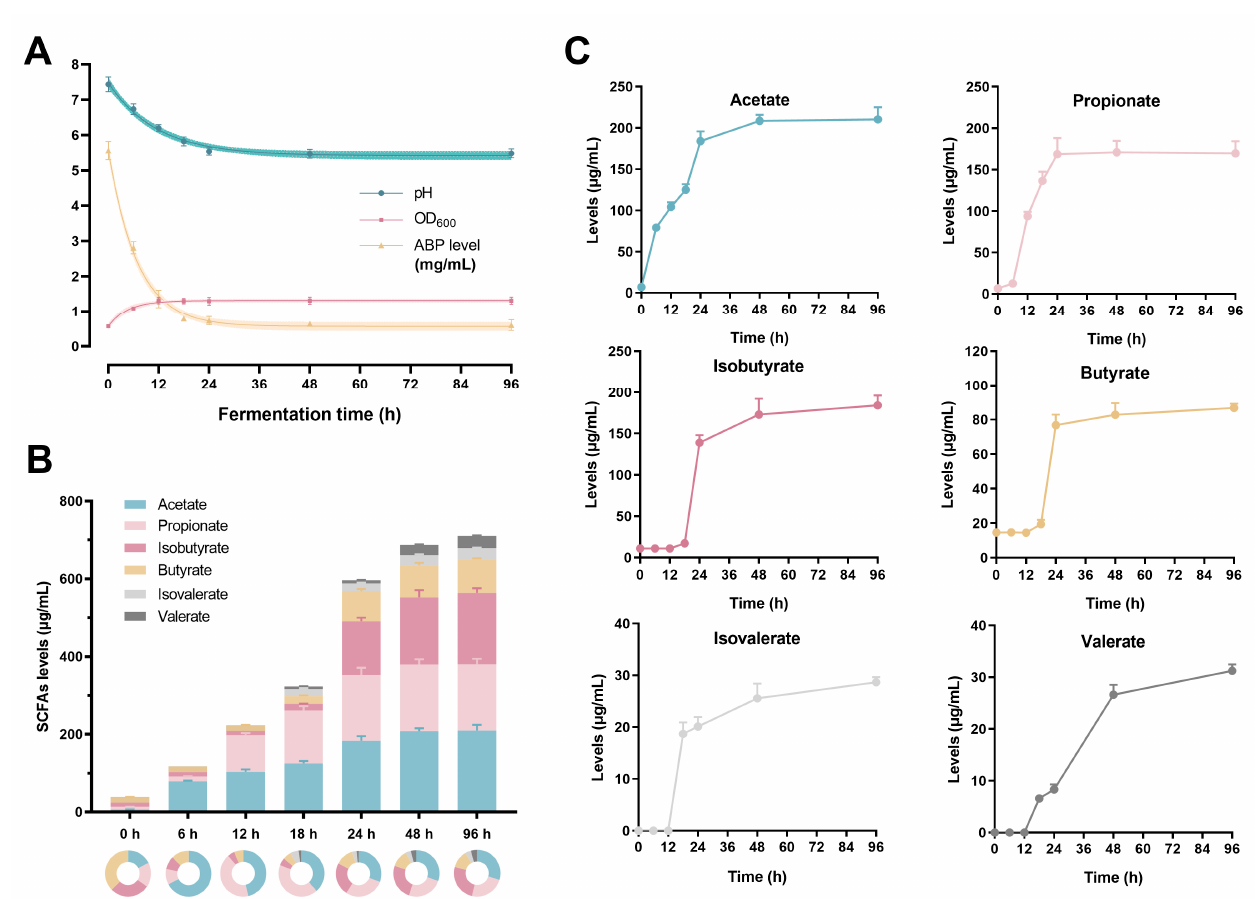
Figure 1. The ABP degradation and SCFAs production during in vitro human fecal fermentation. ( A ) ABP level, pH and OD 600 values at 0, 6, 12, 24, 48 and 96 h; ( B , C ) the SCFAs levels.